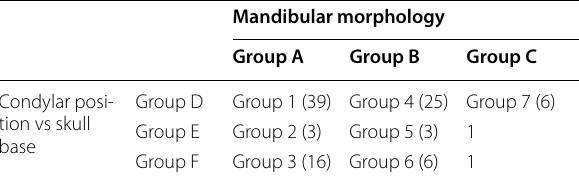
Table 3 Reclassification results based on characteristics of mandibular morphology and condylar position relative to the skull base